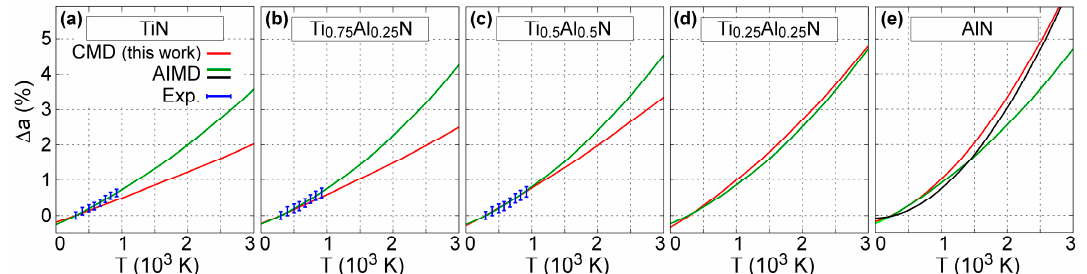
Figure 3. Variation of B1-Ti 1 − x Al x N lattice parameter a as a function of temperature T { ∆ a( T ) = [a( T ) – a(300 K)]/a(300 K)} for ( a ) x = 0, ( b ) x = 0.25, ( c ) x = 0.5, ( d ) x = 0.75, and ( e ) x = 1. AIMD (solid green and black curves) and experimental (blue dots) results are adapted from figure 1 in Ref. [71]. AIMD curves (green lines) shown in the present figure were obtained by fitting the data in the temperature range 0 to 2000 K of Ref. [71] with a second order polynomial. The AIMD curve (solid black line) in ( e ) was obtained using the data presented for B1-AlN equilibrium volume versus T in figure 2a in Ref. [50].